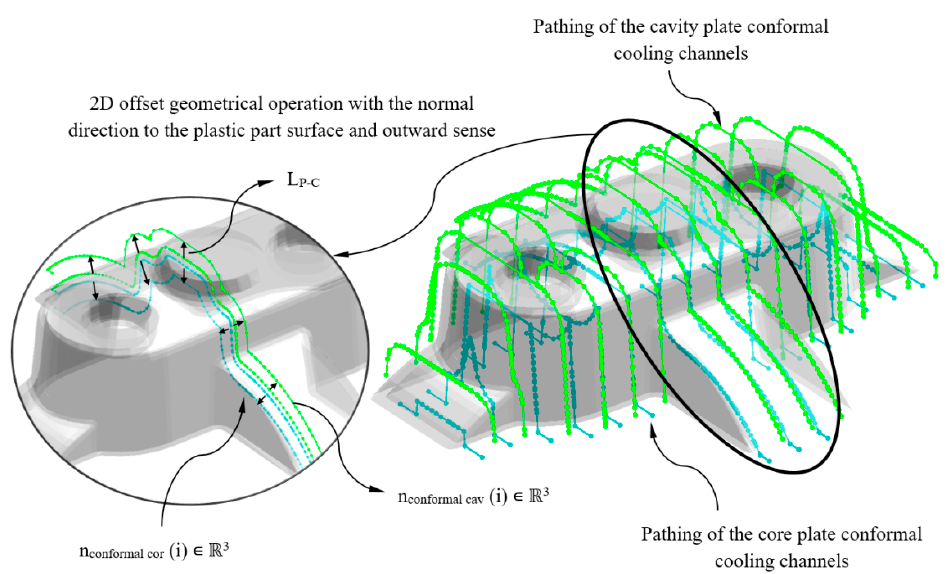
Figure 11. 2D o ff set geometrical operation for defining the conformal cooling channels for the main plates of the cavity and core injection mold.